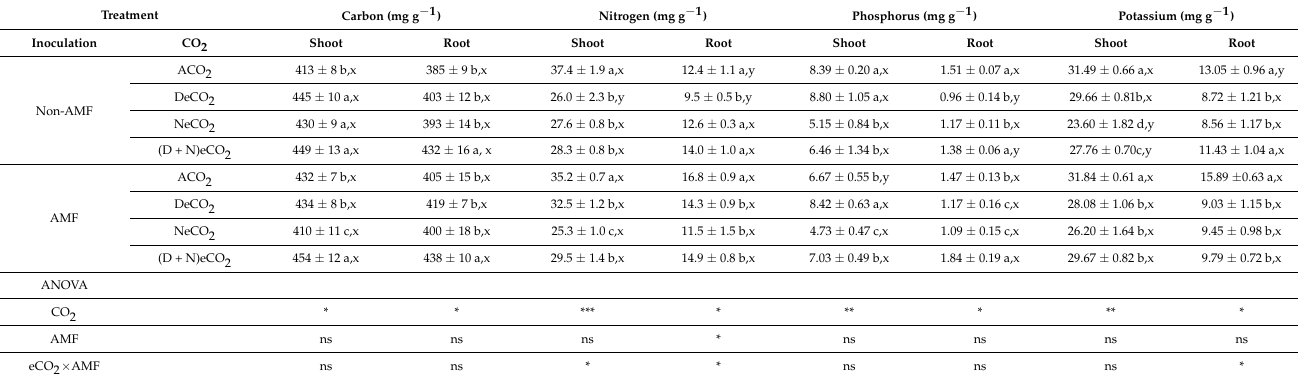
Data (means ± SE, n = 3) followed by different letters indicate significant differences between CO 2 treatments for the same AMF inoculation (a, b, c, d) and between AMF inoculations for the same CO 2 treatment (x, y) at p < 0.05. ANOVA: ns not significant; *, ** and *** indicate significant differences at p ≤ 0.05, p ≤ 0.01 and p ≤ 0.001,